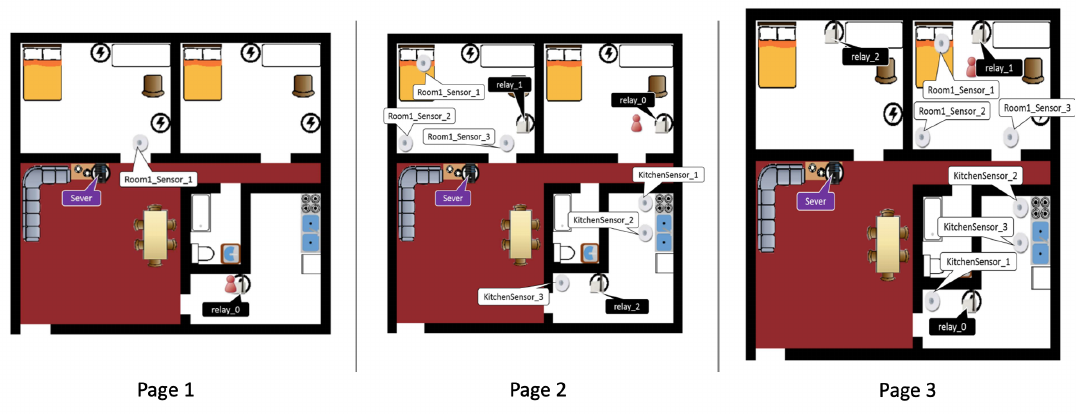
Figure 3. Worked examples in the control group’s instruction